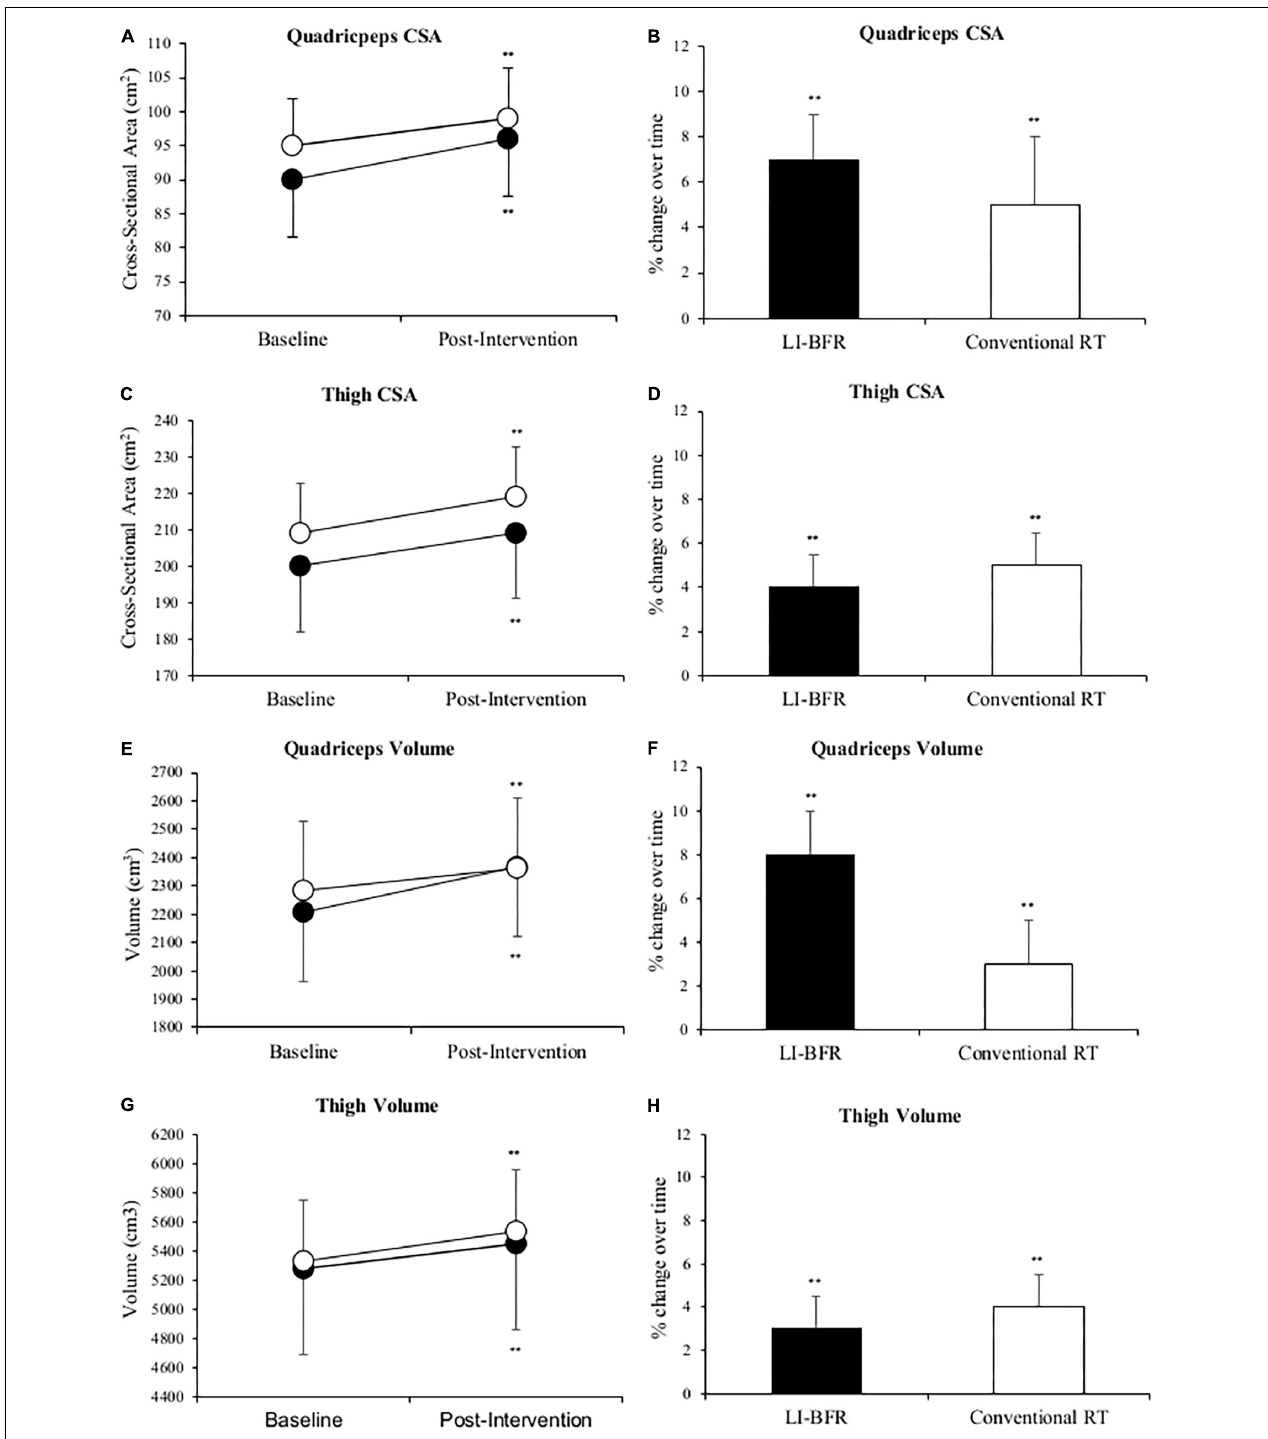
FIGURE 2 | Changes in quadriceps muscle cross-sectional area (CSA) (A,B) , thigh CSA (C,D) , quadriceps muscle volume (E,F) and thigh muscle volume (G,H) at baseline and after 3-weeks of rehabilitation. Black points LL-BFR group, White points Conventional Resistance Training (RT) group. Bar charts show group percent changes over time. Data is expressed as mean ± SD. ∗ p < 0.05 and ∗∗ p < 0.01 versus baseline measurement. Data refers to primary injured limb. LL-BFR, low-load blood flow restriction; RT, resistance training; CSA, cross-sectional area.